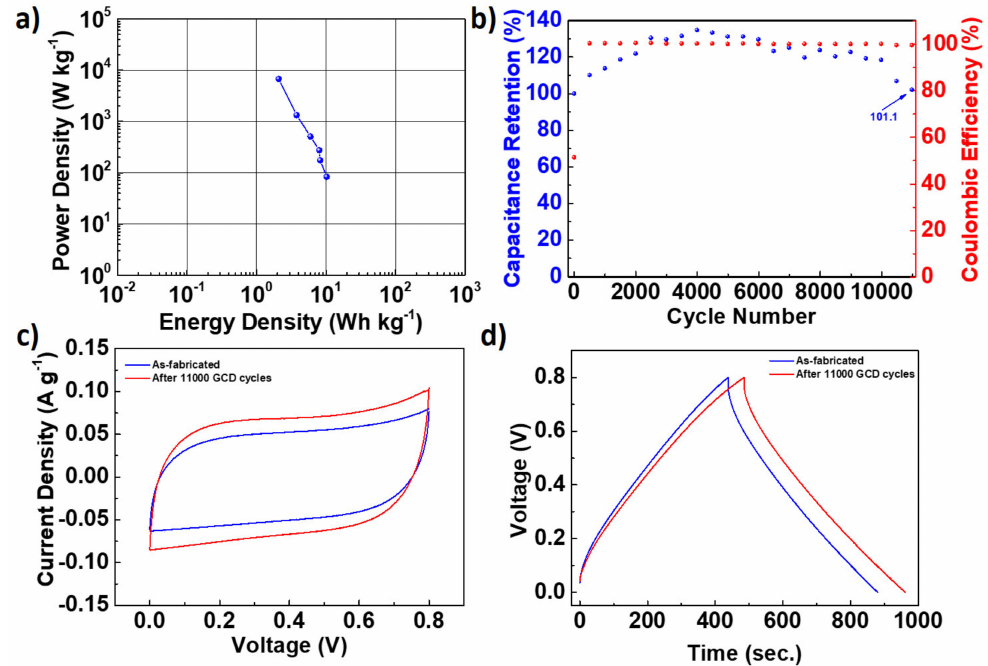
Figure 7. ( a ) Ragone plot of the fabricated supercapacitor. ( b ) The capacity retention of the fabricated supercapacitor was measured with a constant GCD at 1.0 A g − 1 over a voltage range of 0–0.8 V. Comparison of ( c ) CV and ( d ) GCD of as-fabricated and supercapacitors tested over 11,000 cycles.